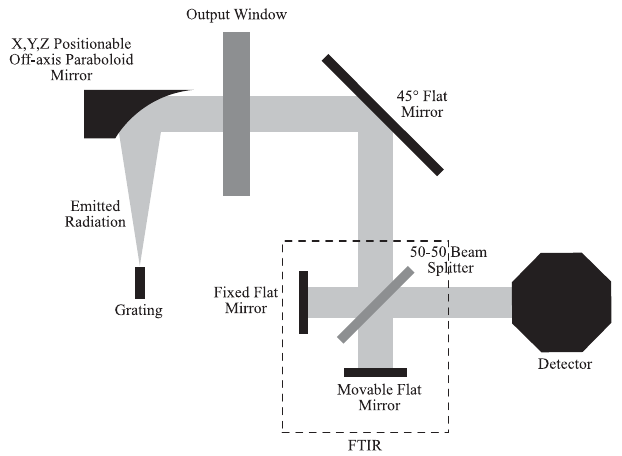
FIG. 3. Radiation produced by the grating is collected and collimated by an off-axis paraboloidal mirror, directed out of the vacuum chamber, through a Michelson FTIR interferometer and into a composite silicon bolometer. In this diagram the electron beam runs into the page above the